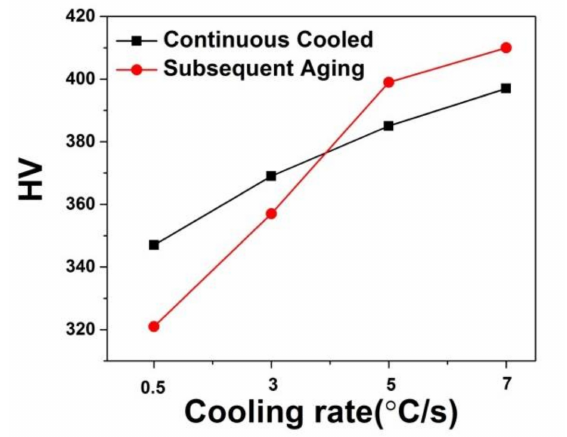
Figure 11. Vickers hardness of the specimens before and after